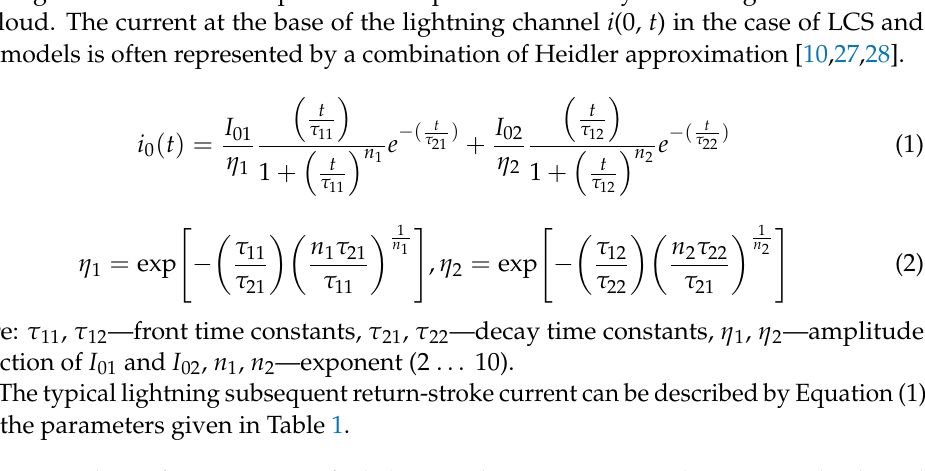
Table 1. Typical waveform parameters for lightning subsequent return-stroke current at the channel base used in Equation